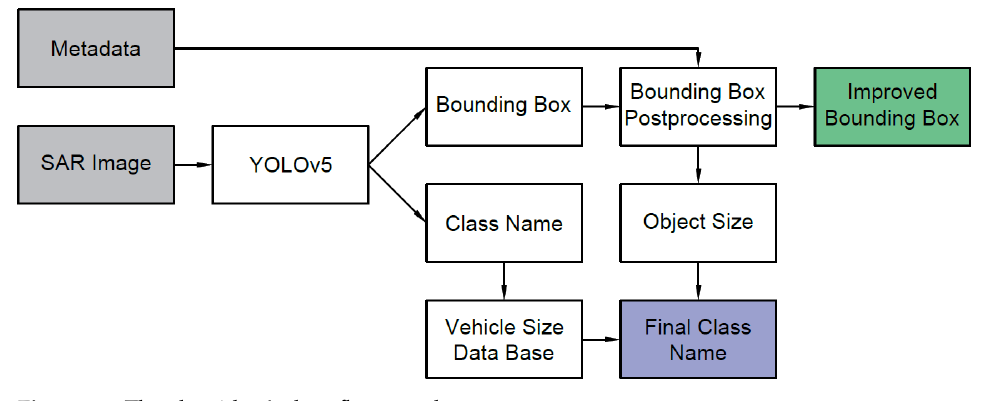
Figure 11. The algorithm’s data-flow graph.